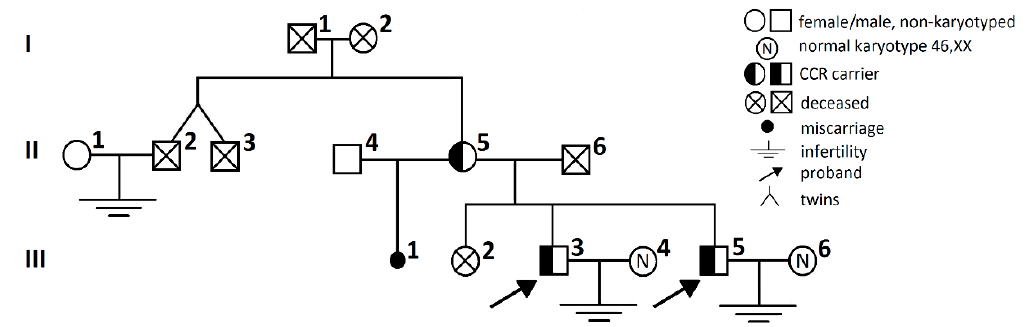
Figure 5. Pedigree information for the CCR t(1;7) family. Two probands are indicated for the brothers (marked with arrows): with azoospermia (brother-1, III-3) and 10 years of lasting infertility, and with cryptozoospermia (brother-2, III-5) and 3 years of lasting infertility. Their mother (II-5), a carrier of the same CCR, revealed one miscarriage at the 12th week of gestation (III-1), and one child death at nine months (III-2), likely due to myelodysplasia (but this was not documented). An infertility case was also noted in another family member (II-2, 20 years of a lack of conception).